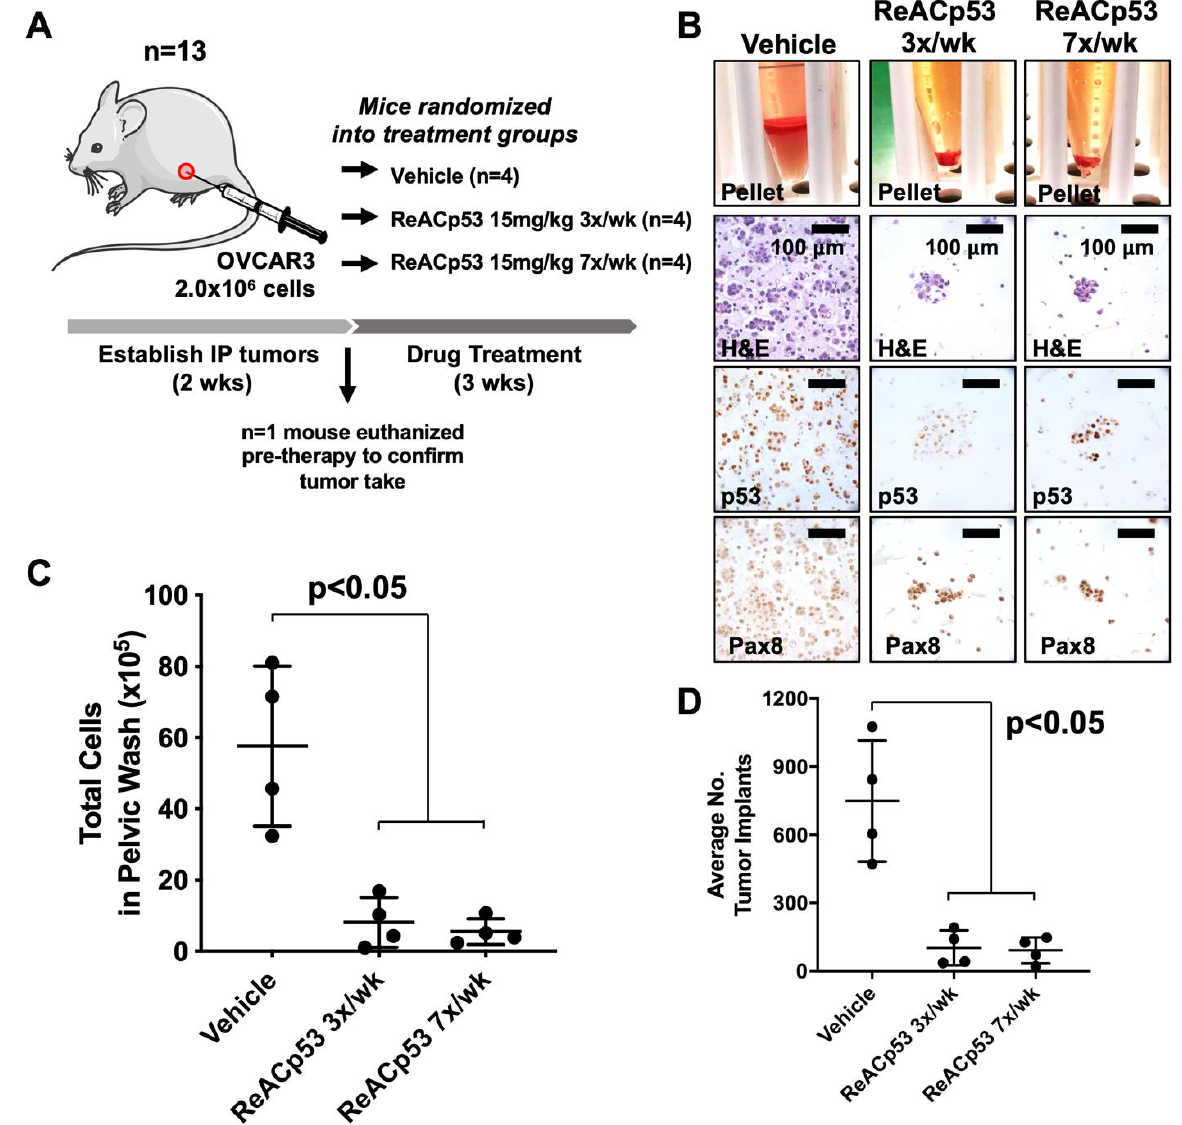
Figure 1. Ovarian cancer xenograft-bearing mice injected with ReACp53 had a smaller disease burden compared to vehicle. ( A ) Xenografts were established by injecting 2.0 × 10 6 OVCAR3 cells into the intraperitoneal (IP) space of n = 13 NSG mice. Following two weeks of tumor establishment, n = 1 mouse was euthanized to confirm tumor take. The remaining n = 12 mice were randomized to receive either vehicle or ReACp53 15 mg/kg (administered 3×/week or 7×/week, IP) for three weeks. ( B ) At the end of therapy, mice were euthanized, IP tumors were harvested by peritoneal lavage, and harvested cells were immunostained for p53 and Pax8 to confirm the presence of tumor cells. Representative cell pellets are shown. ( C ) The total number of cells harvested was quantified for each mouse. Results demonstrated a significant reduction in the number of cells in mice treated with ReACp53 (either 3×/week or 7×/week) compared to vehicle treatment ( p < 0.05). ( D ) Organs harvested from euthanized mice were histologically examined, and the number of tumor implants was quantified across five independent levels per animal and averaged by treatment group (n = 4 animals/group). The average number of tumor implants was significantly reduced in mice treated with ReACp53 (either 3×/week or 7×/week) compared to vehicle ( p < 0.05).